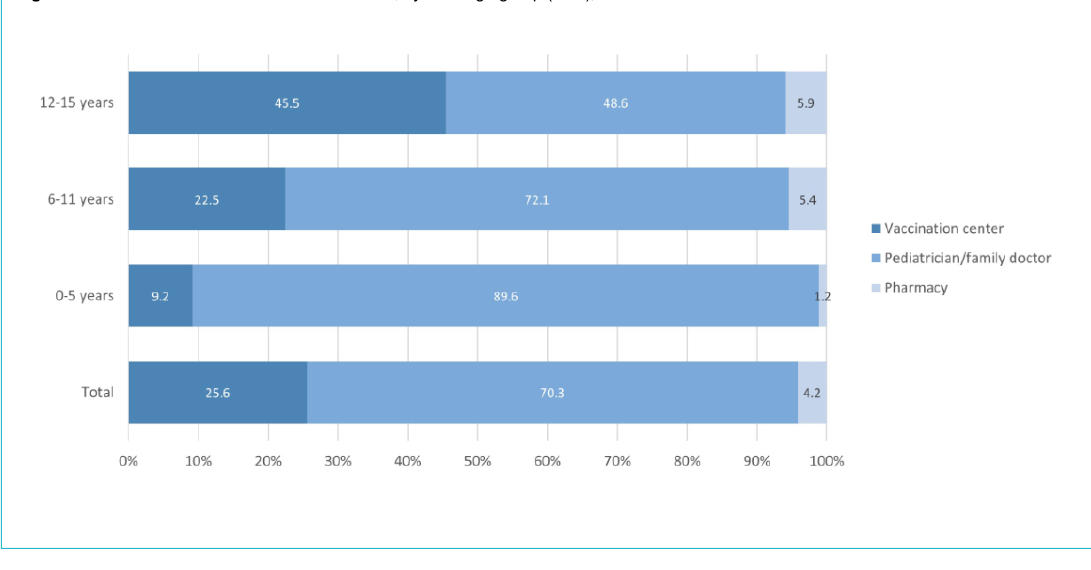
Figure 2: Parental COVID-19 vaccination intention, by child age group (in %); n = 1318